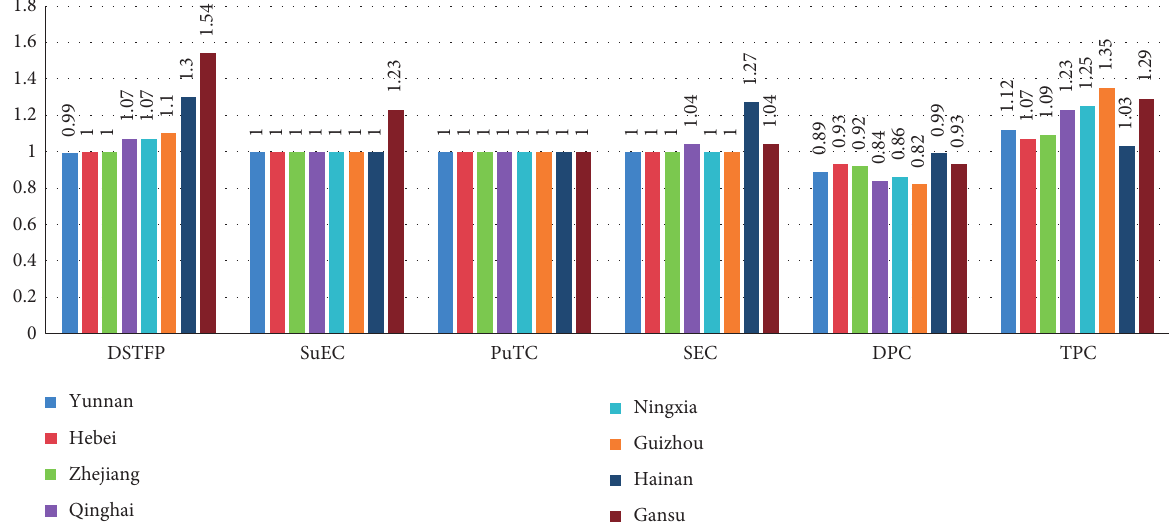
Figure 4: Decomposed efficiency indexes of DPCL.